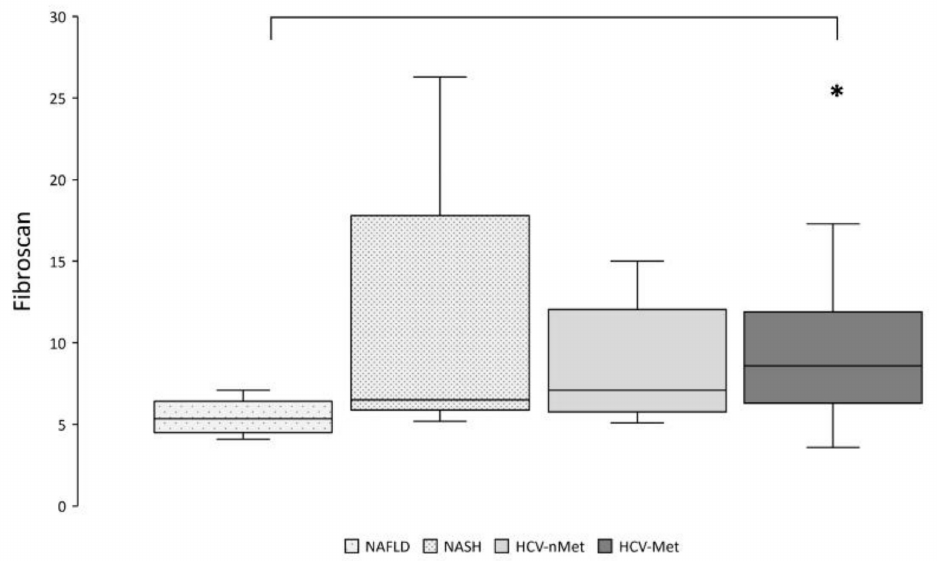
Figure 7. Hepatic fibrosis was assessed by transient elastography (Fibroscan ® ). * p < 0.01 by pairwise analysis.